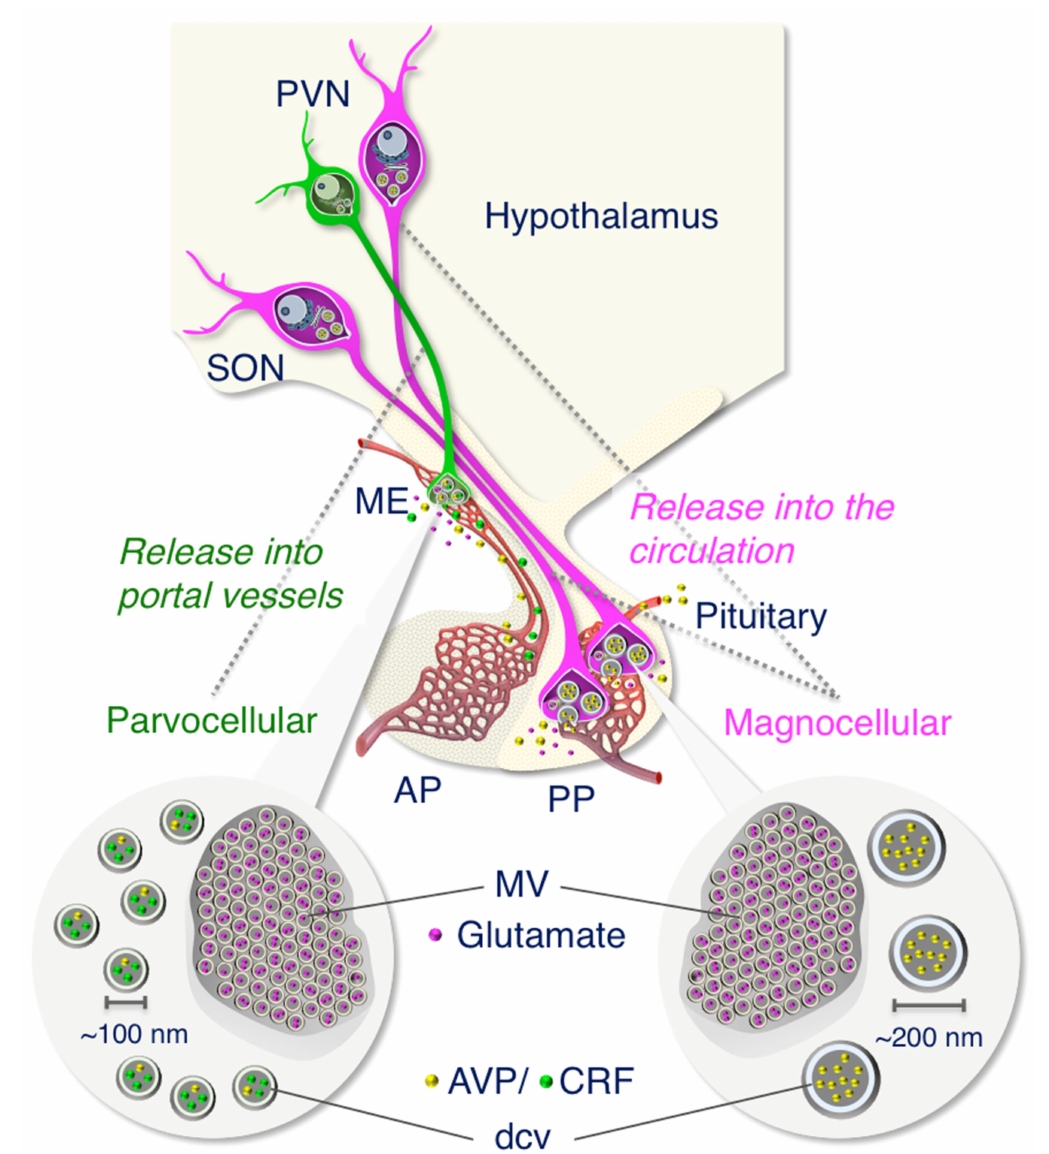
Figure 14. Working model showing that the size difference in dense-cored neurosecretory vesicles (dcv) between magnocel- lular (~200 nm) and parvocellular (~100 nm) vasopressin (AVP)- and/or corticotrophin-releasing factor (CRF)-producing neurons in the hypothalamus of the Japanese macaque monkey. We also demonstrate that both magno- and parvocellular AVP/CRF neurons are glutamatergic in primates. AP, anterior pituitary; ME, median eminence; MV, clustered microvesicles; PP, posterior pituitary; PVN, paraventricular nucleus; SON, supraoptic